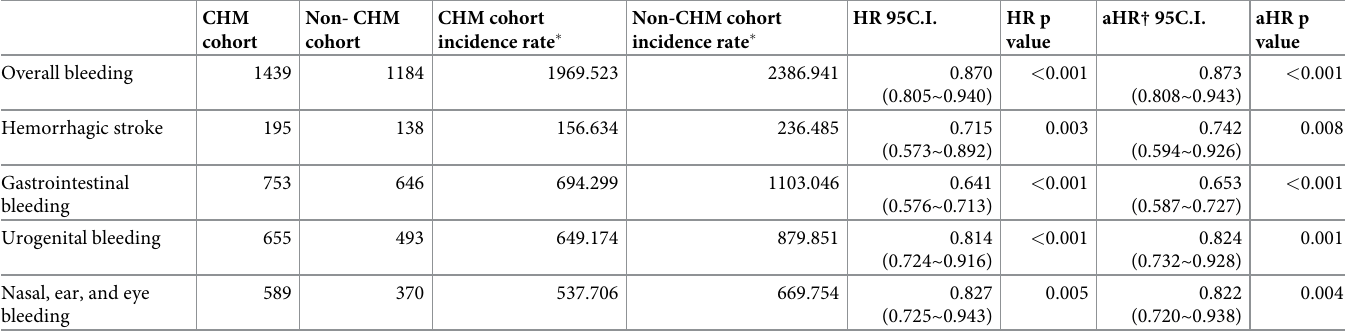
Table 2. Incidence rates, hazard ratios and confidence intervals of different major bleeding events between CHM and non-CHM